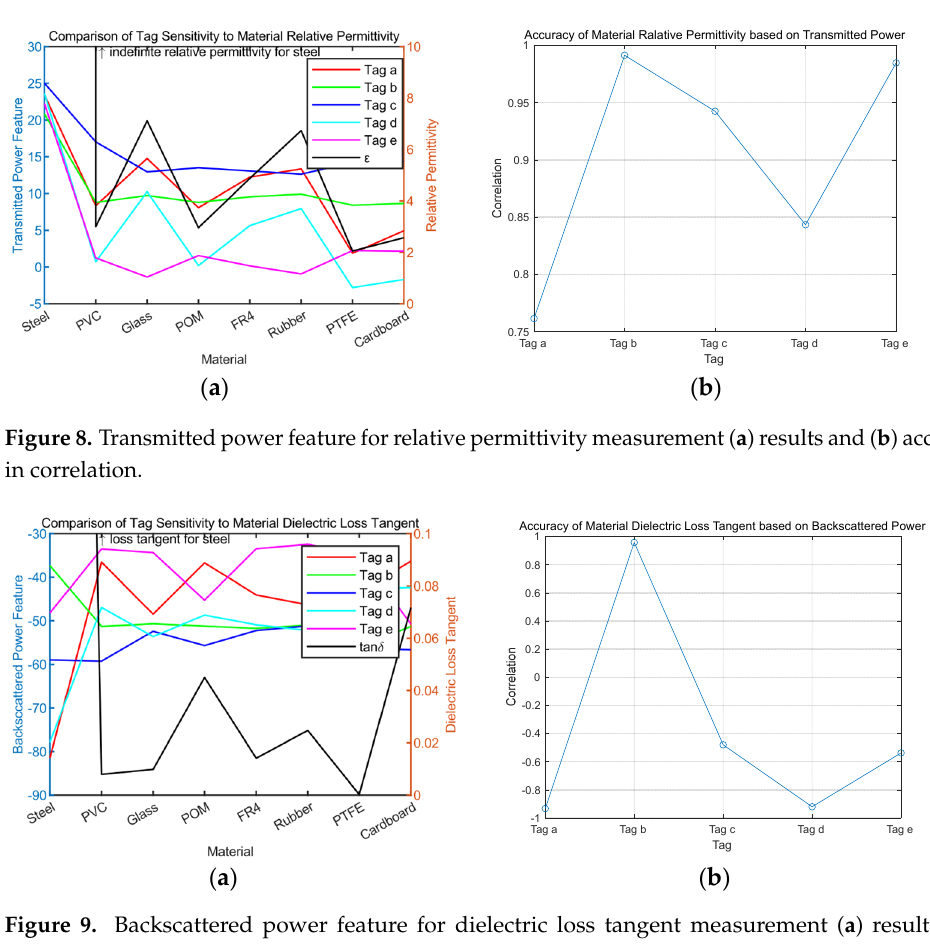
Figure 9. Backscattered power feature for dielectric loss tangent measurement ( a ) results and ( b ) accuracy in correlation.